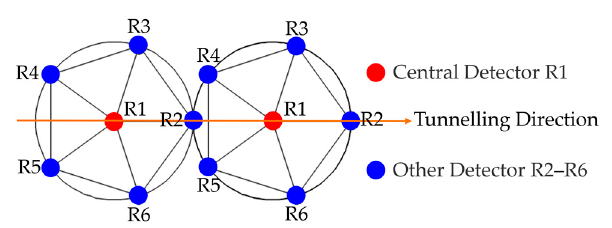
Figure 3. Array Figure 3. Array arrangement.